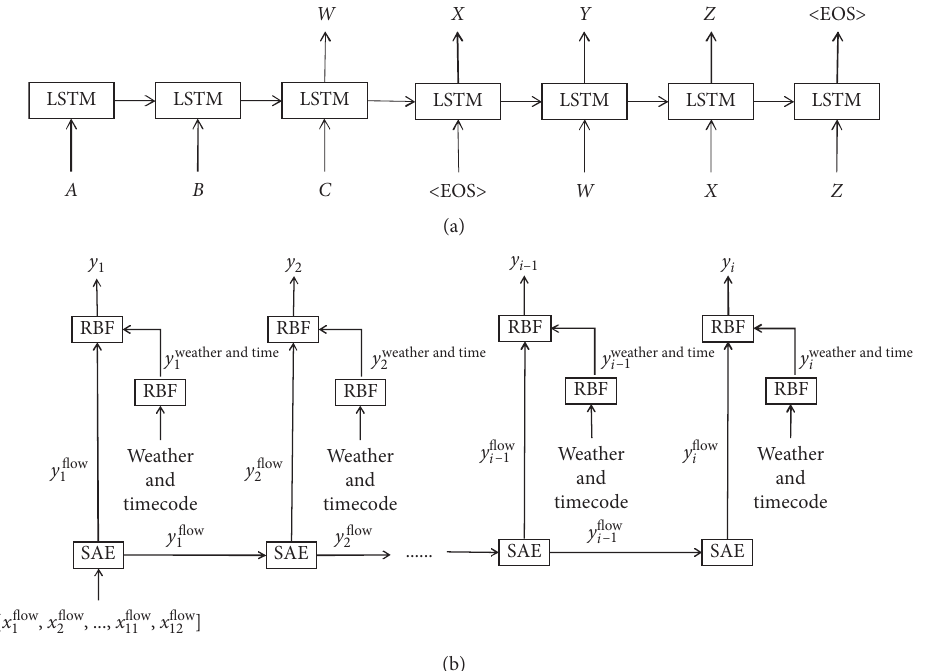
Figure 1: Multistep prediction based on sequence-to-sequence framework. (a) Sequence-to-sequence model. (b) Sequence-to-sequence proposed method.